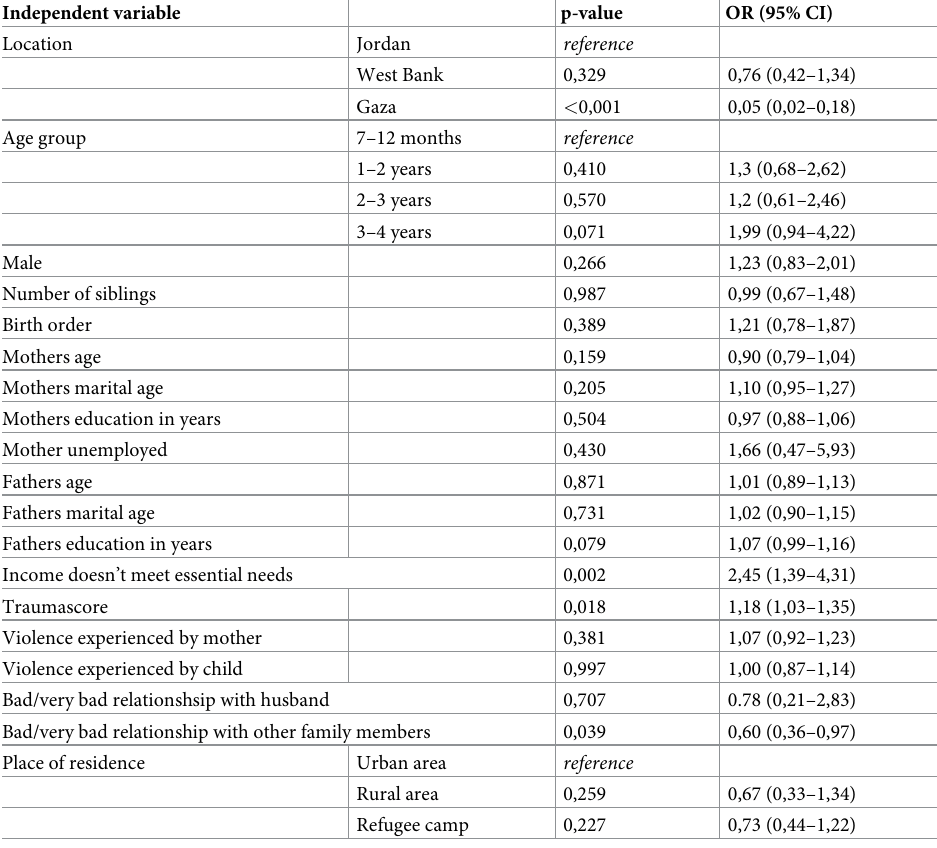
Table 3. Multivariate logistic